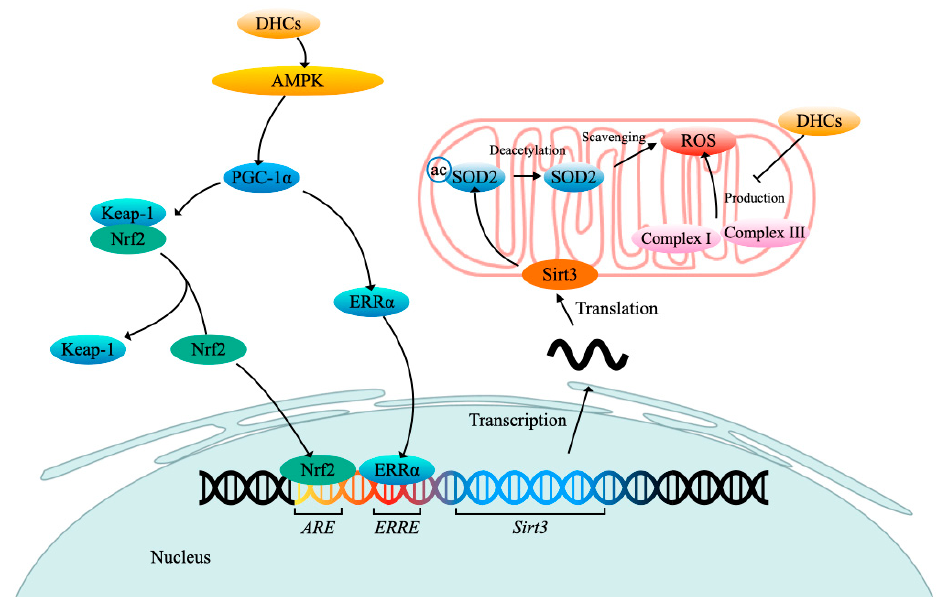
Figure 4. DHCs exert neuroprotection through their antioxidative effect . DHCs, dihydrochalcones; AMPK, AMP-activated protein kinase; PGC-1 α , peroxisome proliferators activated receptor- γ coactivator-1 α ; Keap-1, Kelch-like ECH-associated protein 1; Nrf2, Nuclear respiratory factor 2; ARE, antioxidant response element; ERR α , estrogen-related receptor α ; ERRE, ERR α response element; Sirt3, sirtuin 3; SOD2, superoxide dismutase 2; ac, acetylation; ROS, radical oxygen species. Arrow ( → ) indicates activation, and the blunt arrow (-- | ) indicates inhibition.